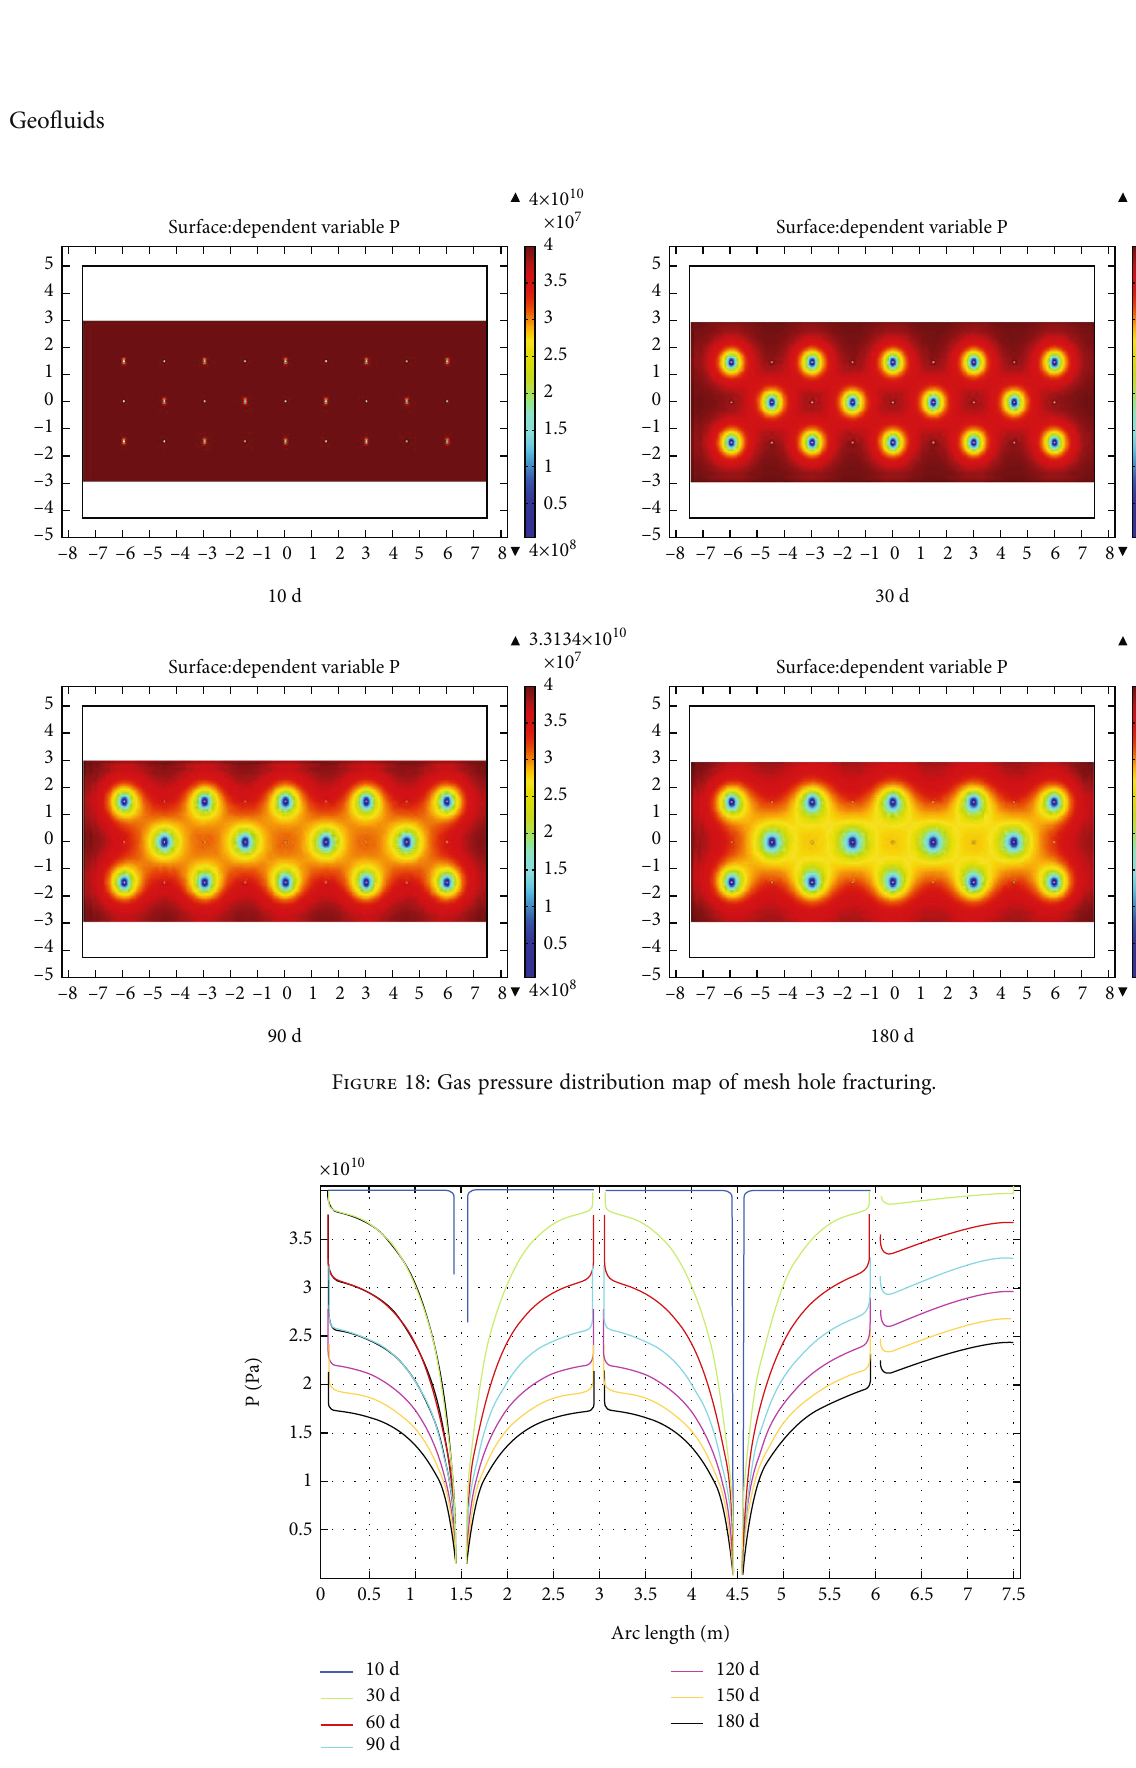
Figure 19: Curves of gas pressure versus distance in mesh